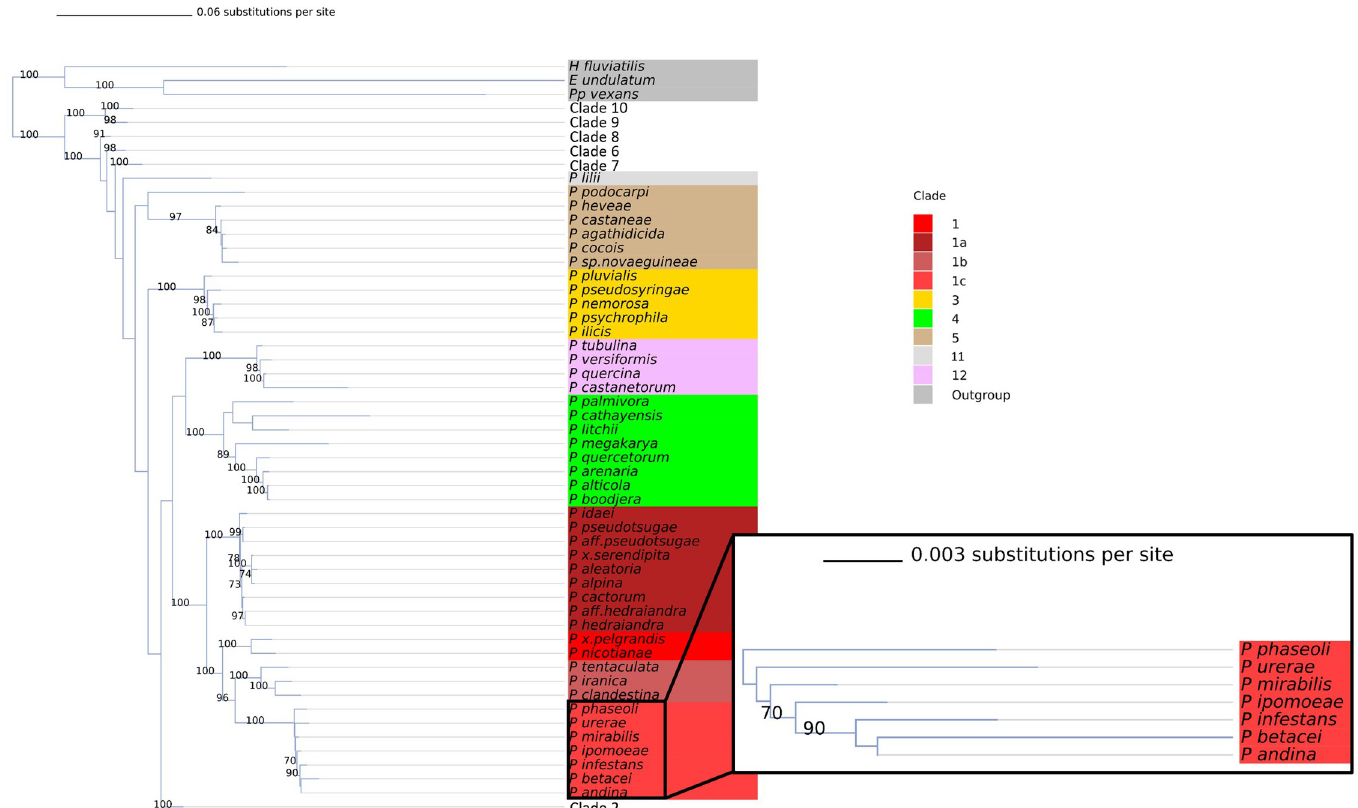
Fig 4. Phylogeny of clades 1, 3 4, 5, and 12. Collapsed phylogeny of the genus Phytophthora showing clades 1 (red), 3 (yellow), 4 (green), 5 (beige), and 12 (pink) in detail. Subclade values are shown as variations in color hue. Phylogeny is inferred using maximum likelihood and 1,000 bootstrap replicates for an alignment of 8 concatenated nuclear loci. Bootstrap values (in percent) are shown above each branch. The branches in the tree are drawn to scale and the scale bar represents 0.06 substitutions per site (0.003 substitutions per site in the inset).